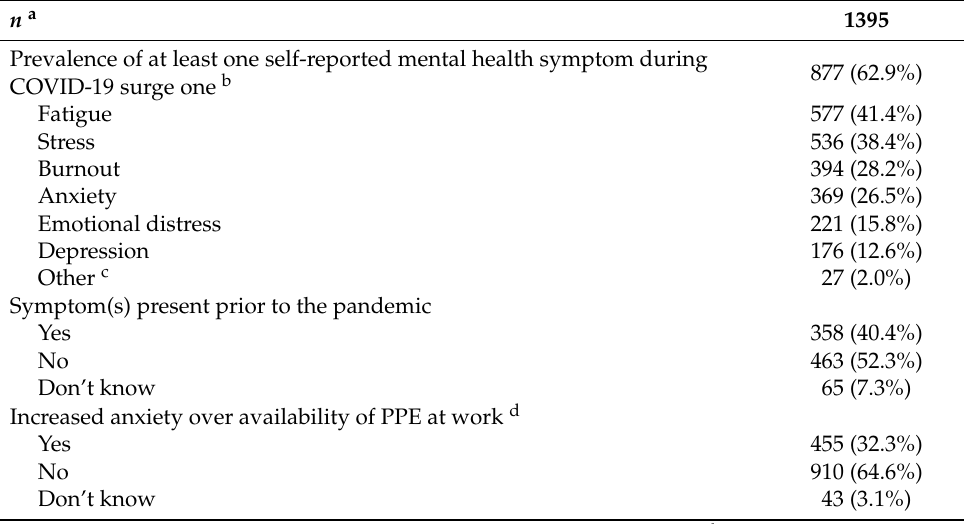
Table 6. Prevalence of self-reported mental health issues among survey respondents during COVID- 19 surge one. n